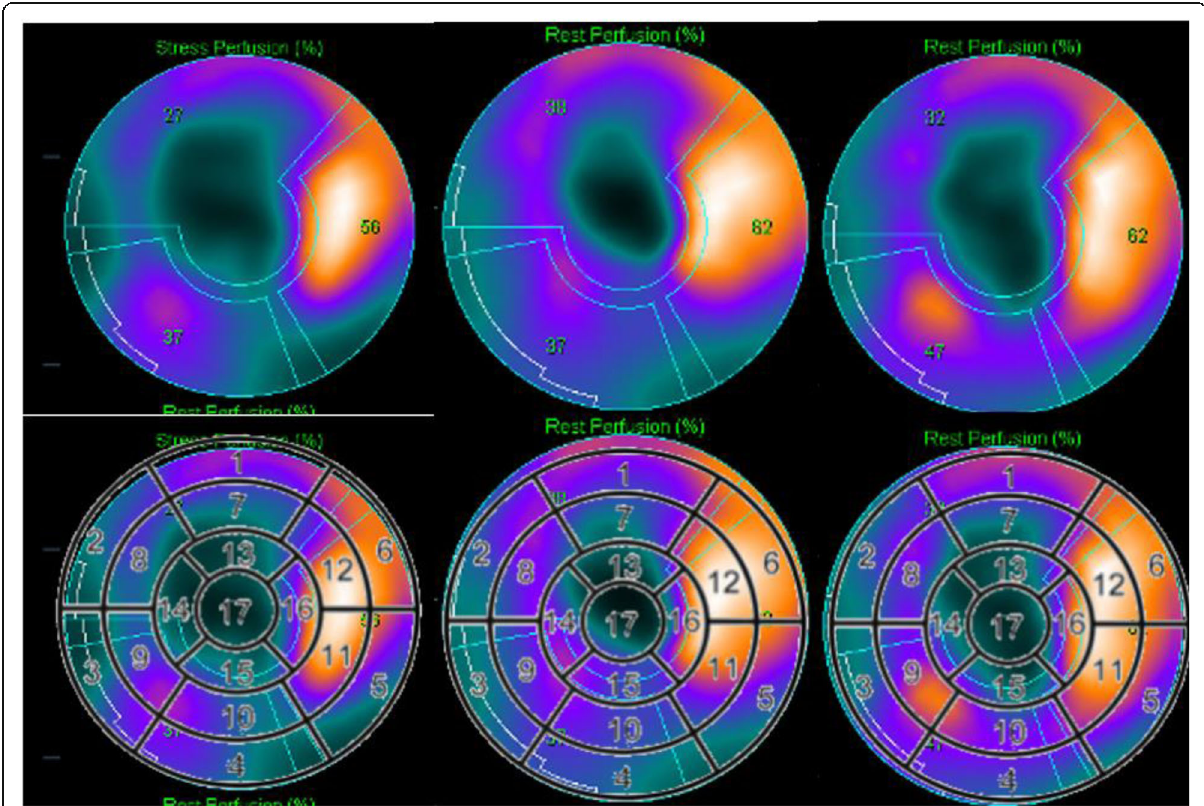
Fig. 8 Polar map in stress, early rest, and delayed rest of MPS of 62-year-old male patient presented with severe chest pain radiating to the back, diabetic, hypertensive, and smoker classified clinically to be high risk. His perfusion scan demonstrated large severe hypoperfusion in the stress study involving the apex as well as the apical and mid segments of the anterior wall. The latter demonstrated partial recovery in the rest phase. SSS = 18, SRS = 12, and SDS 6. EF was 32%. Her GWR was